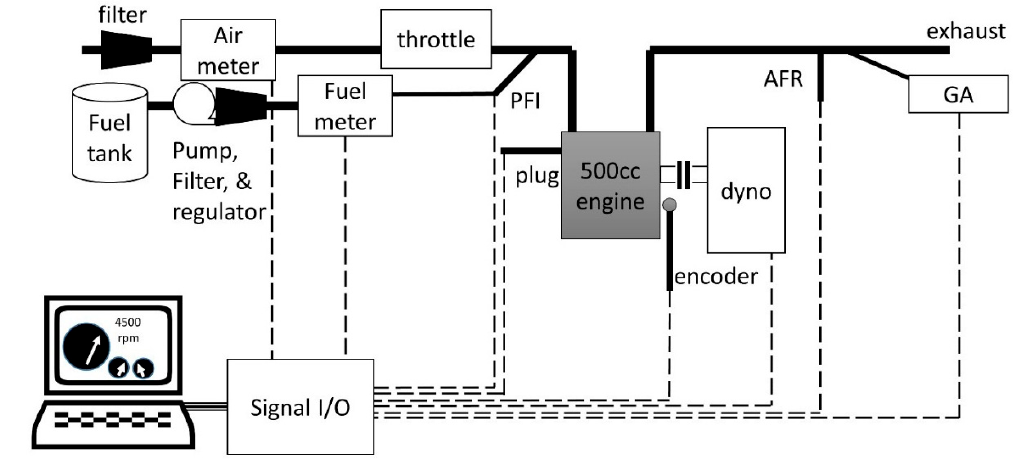
Figure 2. Single-cylinder engine mode. Table 2. The measurement ranges and uncertainties for major